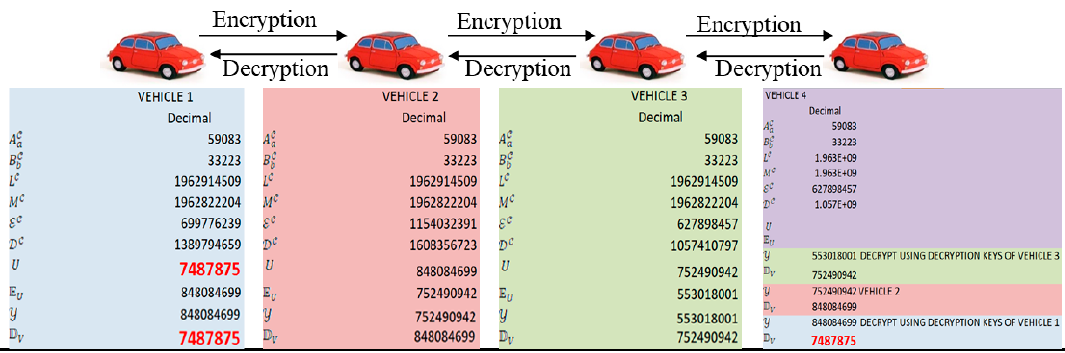
Table 2. Channel parameters for different environments used for simulation [21].